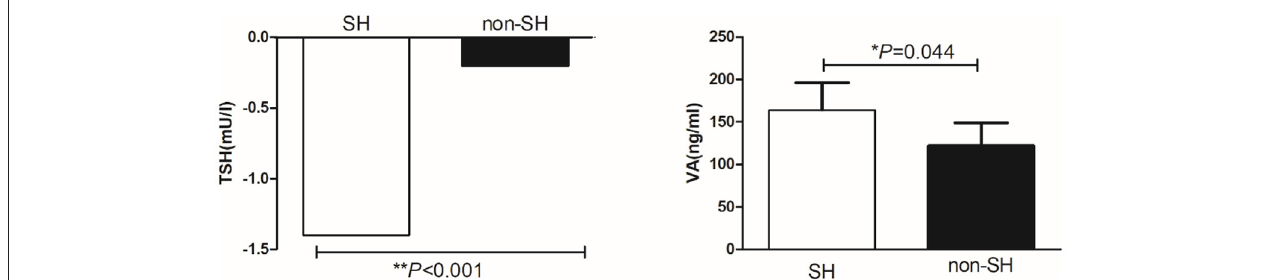
FIGURE 6 | Comparison of change in TSH and VA between obese patients with or without SH.